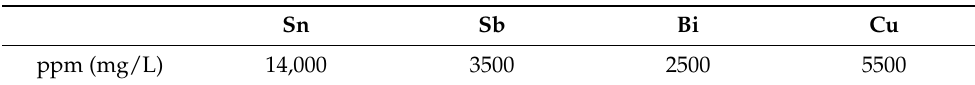
Table 2. The concentrations of the simulated